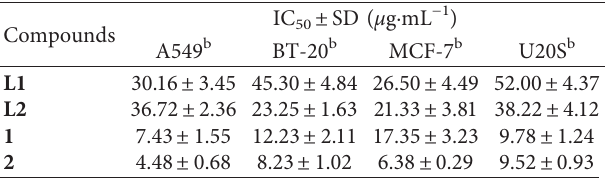
Table 10: Tests of IC 50 ( μ g/mL) of the ligands and complexes against cancer cells a .